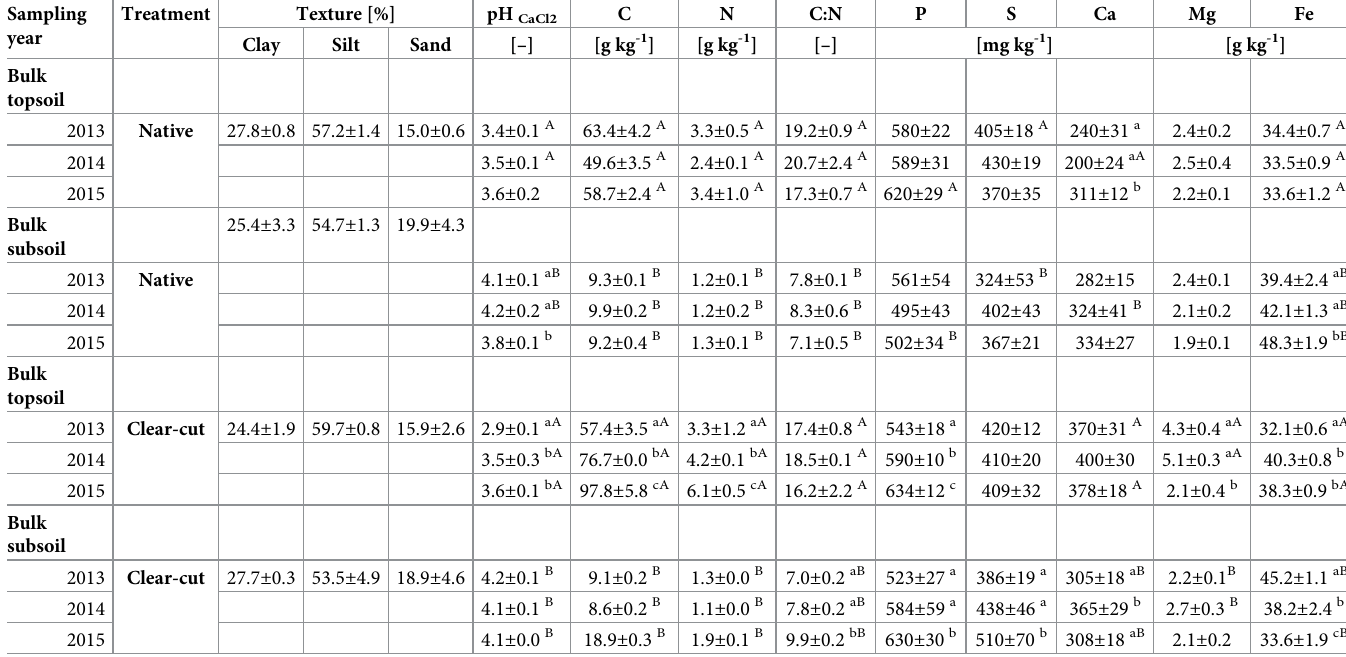
Table 1. Bulk soil texture, pH CaCl2 values and elemental composition given as mean ± standard deviation (SD) (n = 3). Total C and N concentrations were deter- mined by dry total combustion, all other total elemental concentrations were determined by microwave-assisted digestion in aqua regia . Different lowercase letters indicate significant ( P < 0 . 05 )differences with time for bulk samples, respectively, whereas different uppercase letters indicate significant differences of bulk samples at the respective sampling time.